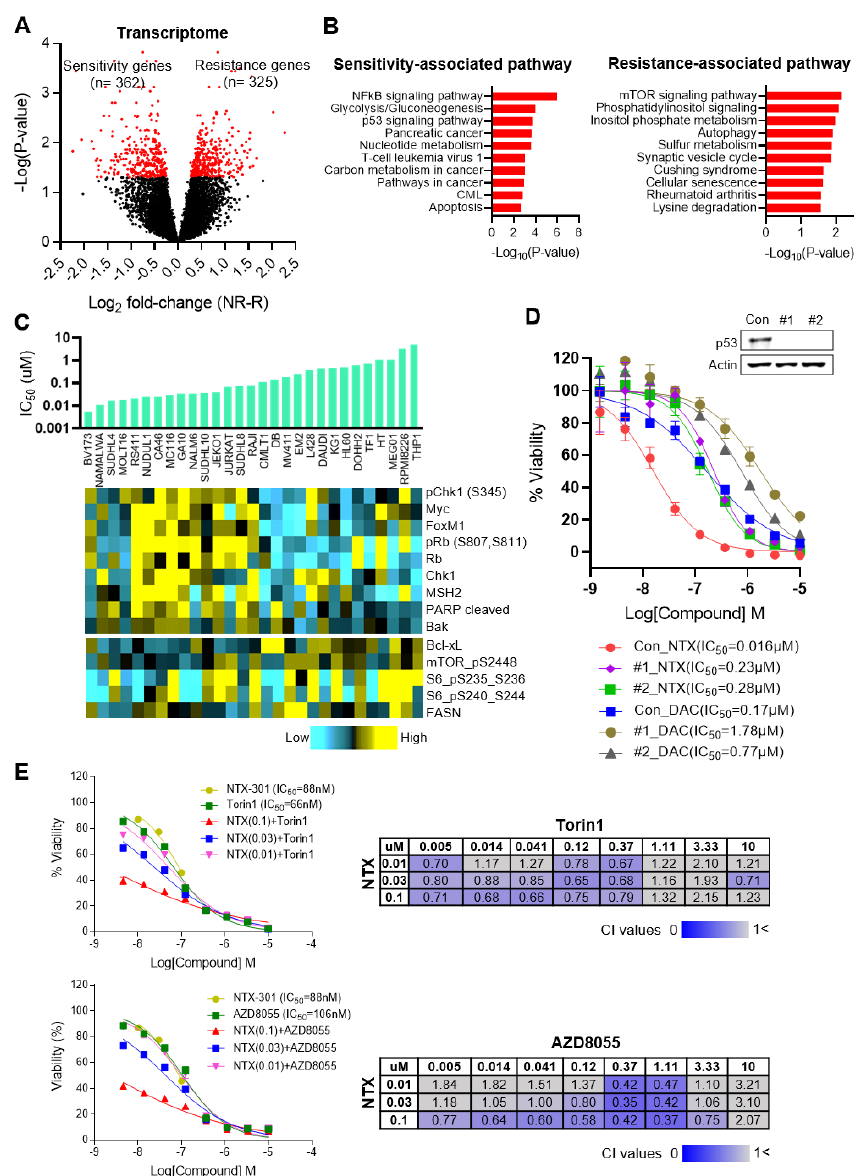
Figure 5. Integrative analyses using 199 CCLs identified transcriptional events that are associated with sensitivity to NTX-301. ( A ), A volcano plot showing transcriptional events that are associated with sensitivity to NTX-301. On the X-axis, ‘log 2 fold-change(NR-R)’ indicates the log 2 -transformed fold change in the expression of each gene in the nonresponders (NR) relative to the responders (R). The red dots highlight significant events that were identified by the cutoff criteria of p < 0.05. ( B ), Bar plots showing biological pathways that are significantly associated with sensitivity or resistance to NTX-301 at the transcriptome level. ( C ), Image integrating IC 50 values upon NTX-301 treatment (bar plot) and protein expression levels from the Cancer Cell Line Encyclopedia (CCLE) RPPA data (heatmap) in 29 blood CCLs. ( D ), Dose–response curves of MV4-11 parental (con) and p53-KO cell lines (#1, #2) after treatment with NTX-301 or DAC for 3 days. p53 KO was confirmed by western blotting. ( E ), IC 50 curves of NTX-301 and the mTOR inhibitors Torin1 (top) and AZD-8055 (bottom), used as monotherapy or in combination (left). Matrices show the combination index (CI) values of NTX-301 + mTOR inhibitors at the indicated concentrations in MV4-11 cells (right). CI values < 1 indicate synergism (blue), and CI values > 1 indicate no synergism (gray).